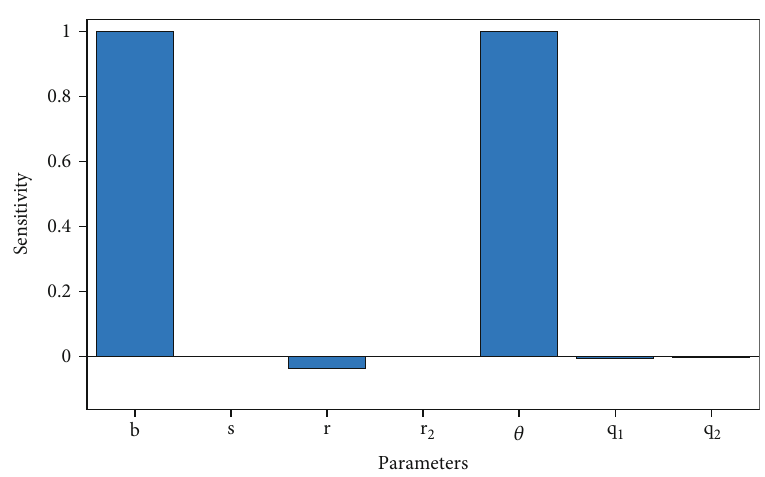
Figure 7: Global sensitivity analysis of model (7) based on R